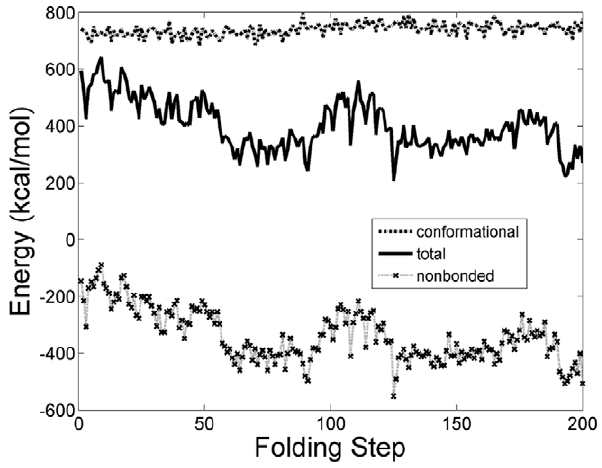
Figure 7. Components of the internal energy. Conformational energy (bonds, angles, dihedrals, and impropers), nonbonded energy (vdW and electrostatic energy), and total energy are compared. Nonbonded energy determines the general trend of the total energy.